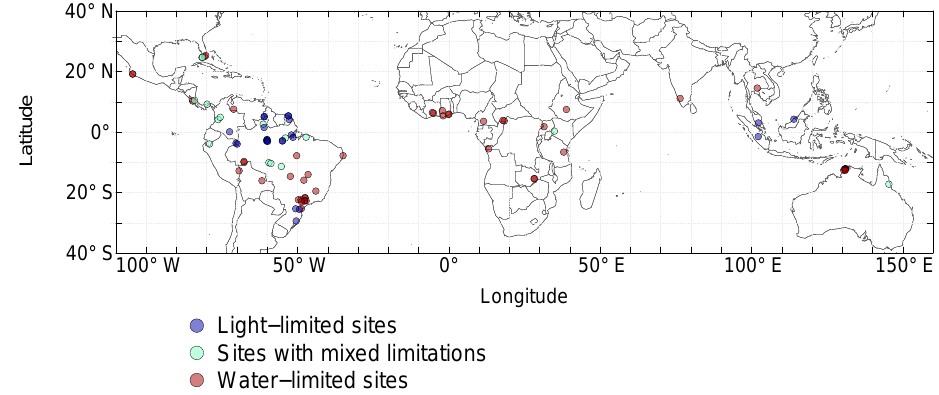
Figure 7. Locations and climate limitations of the 89 experimental sites. water-limited sites ( (cid:49) EVI wet-dry > 0 . 0378), sites with mixed limitations ( (cid:49) EVI wet-dry [ − 0.0014; 0.0378]) and light-limited sites ( (cid:49) EVI wet-dry < − 0 . 0014), (Fig. 6 for the definition of the thresholds).